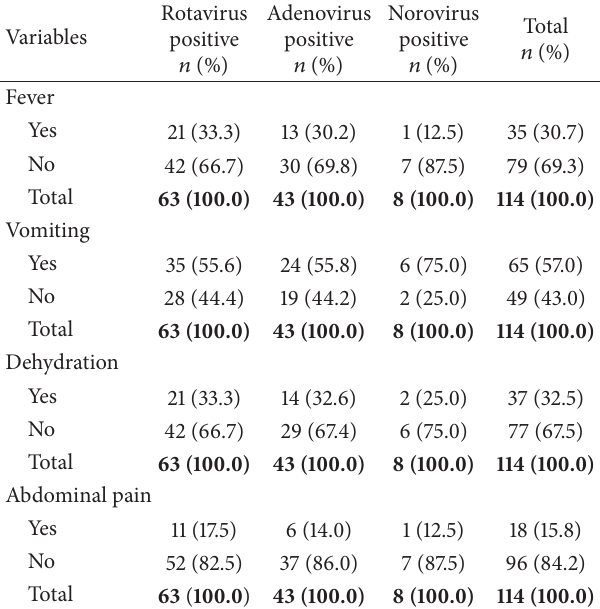
Table 5: Distribution of rotavirus, adenovirus, and norovirus positive patients by some